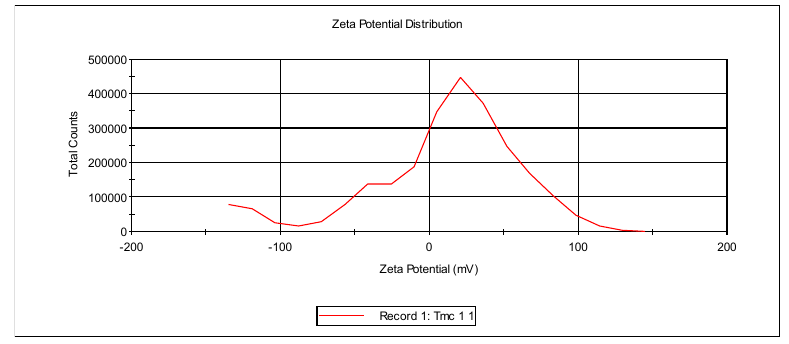
Fig. 2. D-glucosamine nanoparticles electric charge analysis with zeta sizer.